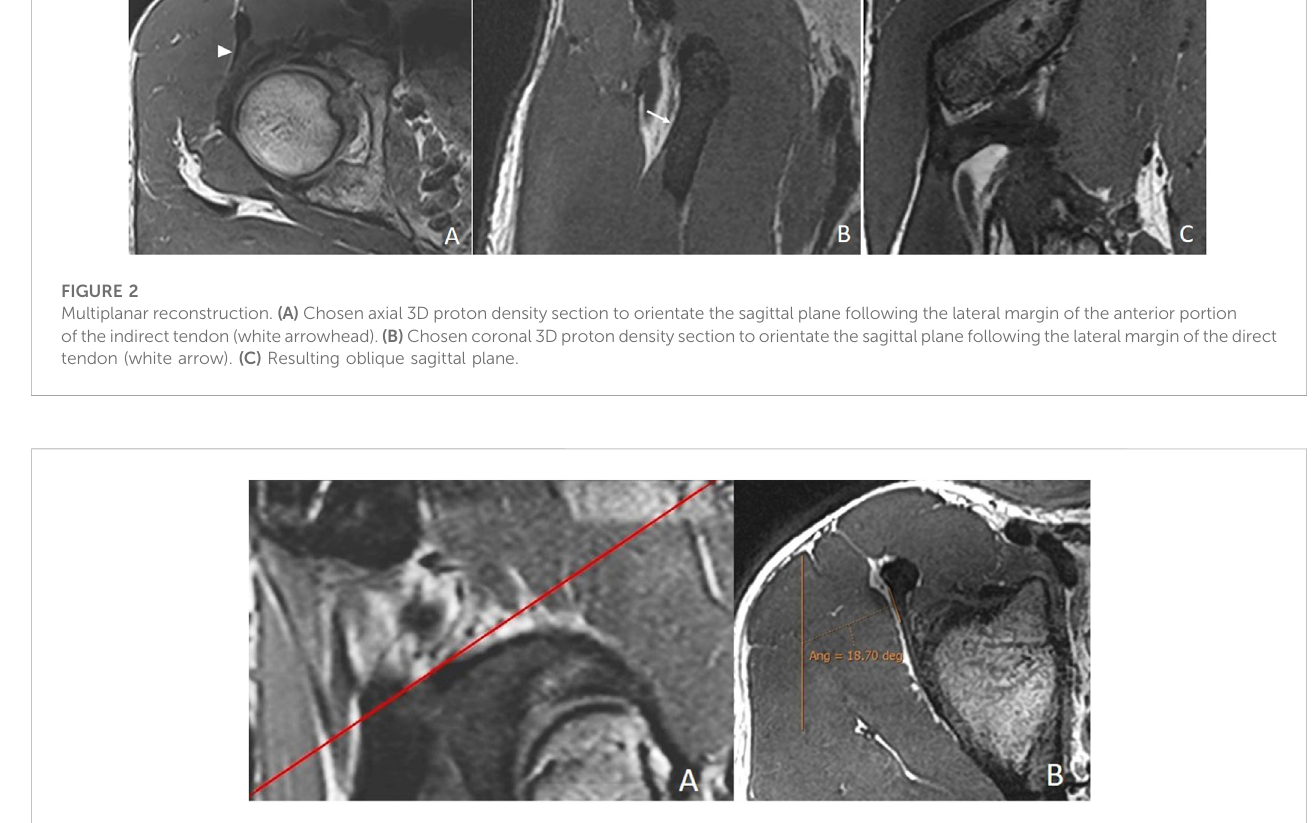
FIGURE 3 Measurement of the indirect tendon slope. (A) Sagittal 3D proton density with the reference line to obtain the batch of the oblique axial reconstruction following the orientation of the indirect tendon. (B) Median section of the oblique axial reconstruction of the indirect tendon with measurement of its inclination (indirect tendon anterolateral margin/anteroposterior axis). The portion of the CT is excluded. In this case, the merging of the indirect tendon with the CT in the axial plane is more lateral than the acetabular insertion of the indirect tendon, and the inclination is negative ( − 18.7 ° ).